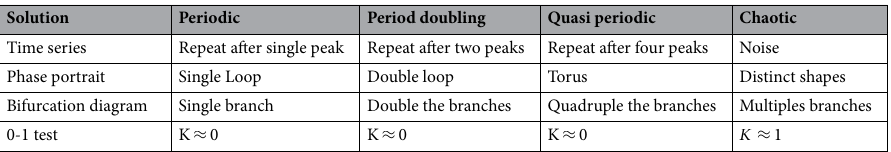
Table 2. Solution of dynamics of the forward